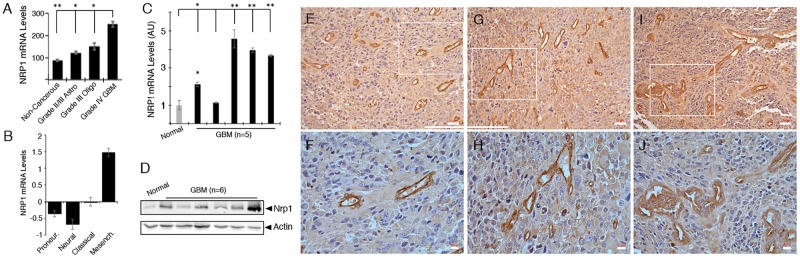
NRP1 RNA and protein expression are upregulated in human GBM tissues.(A); Analysis of GBM TCGA reveal that NRP1 RNA expression levels show progressive upregulation depending on tumor grade, with GBM samples expressing the highest levels of NRP1, *p<0.05 and **p< 0.01 for GBM in relation to lower-grade tumors and non-cancerous control brain. (B); NRP1 is a molecular marker for the mesenchymal GBM sub-type based on analysis of the GBM TCGA database. (C); Quantitative RT-PCR using RNA from a non-cancerous control brain tissue (normal) or five different GBM samples, *p<0.05 and **p< 0.01 for GBM in relation to normal control brain tissue. (D); Anti-Nrp1 immunoblot using detergent-soluble lysates from non-cancerous control brain tissue or six different freshly resected GBM specimens. Note that in comparison to control brain, Nrp1 protein levels are higher in five of the six tumor samples. (E-J); Immunohistochemistry stains using an anti-Nrp1 antibody reveal robust Nrp1 protein expression in three different human GBM samples. Note that Nrp1 protein is expressed in GBM cells as well as in intratumoral blood vessels. Lower panels (F, H, J) are higher magnification images of boxed areas in upper panels (E, G, I). Scale bars, 50 μm in D-F and 20 μm in G-H. All error bars represent standard deviation.